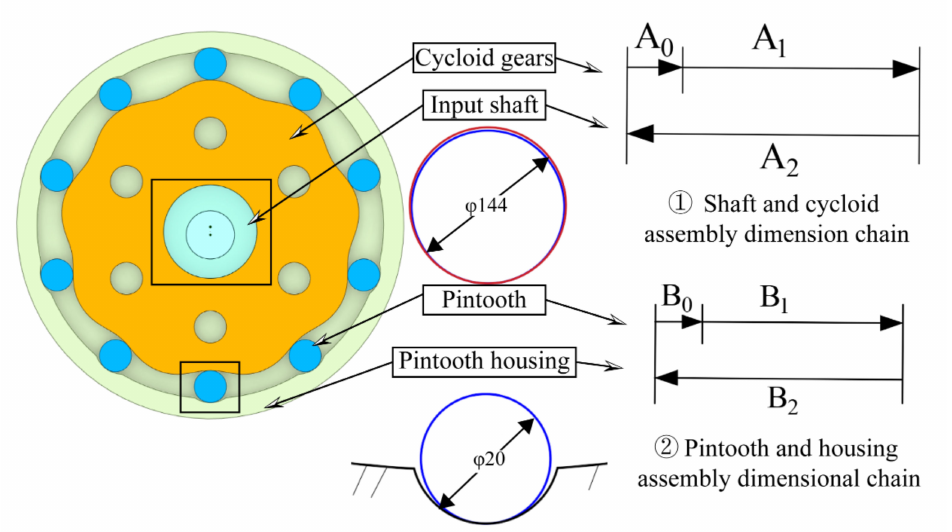
Figure 9. Assembly dimension chain of the original structure.